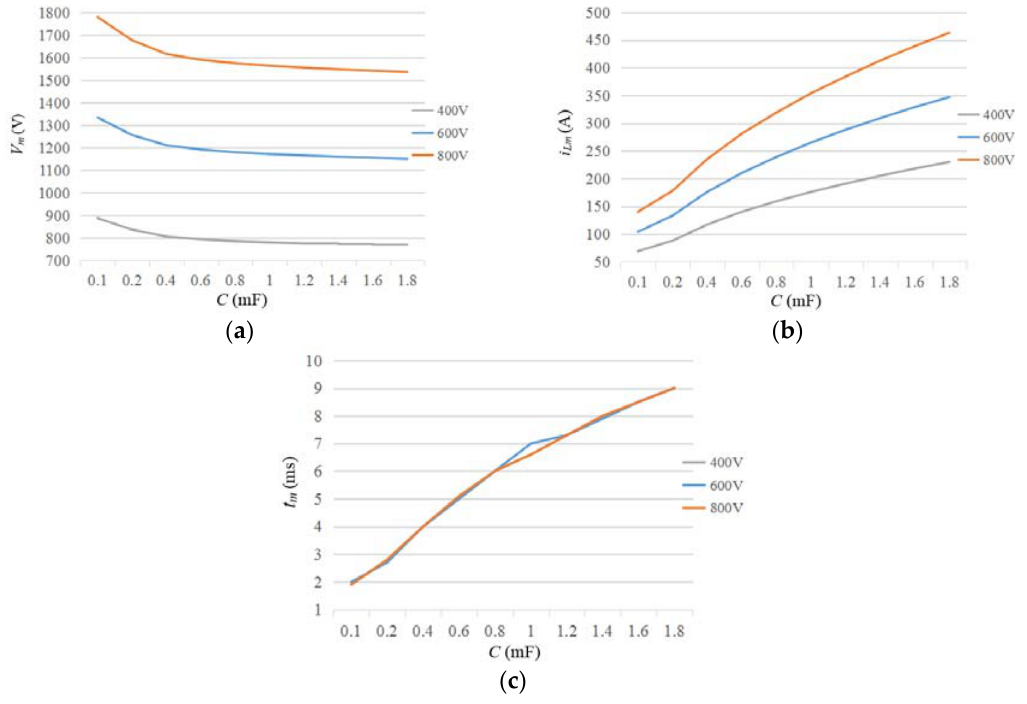
Figure 8. Relationship between capacitance C and key variables: (a) the relationship between V m and Figure 9. Energy release phase equivalent circuit diagram. C; (b) the relationship between i Lm and C; (c) the relationship between t m and C. C; ( b ) the relationship between i Lm and C; ( c ) the relationship between t m and